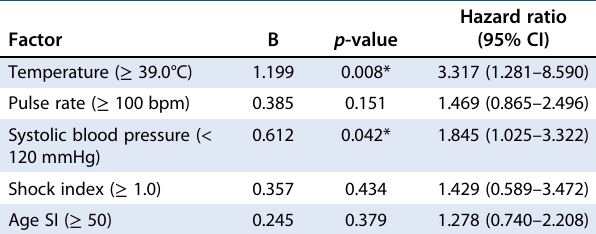
Hazard ratio (95% CI)